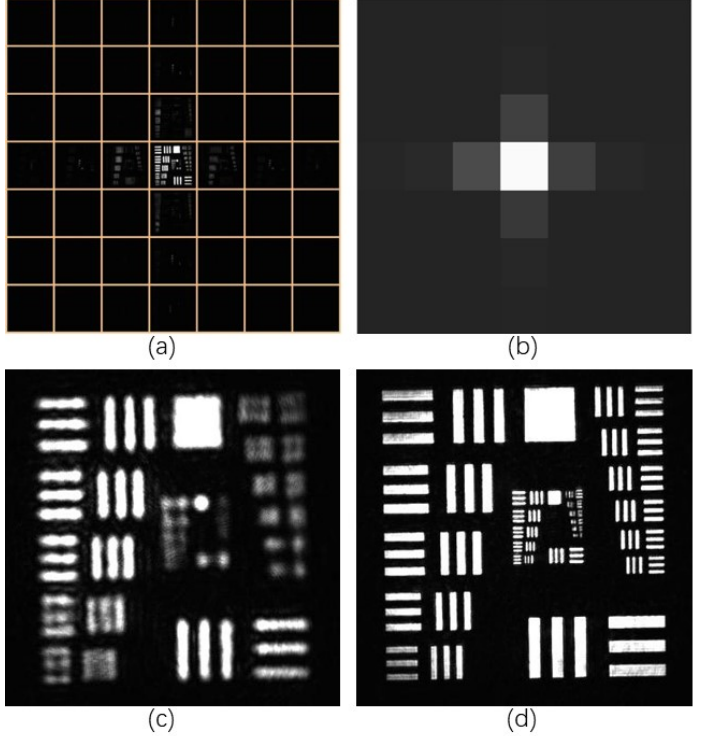
Figure 6. ( a ) Images were taken at different positions. ( b ) Image intensity sum corresponding to ( a ) position, where the square brightness is proportional to the corresponding image intensity. ( c ) The image was taken in the central position. ( d ) The images captured by the large aperture are used as a reference to evaluate the quality of the reconstructed image.